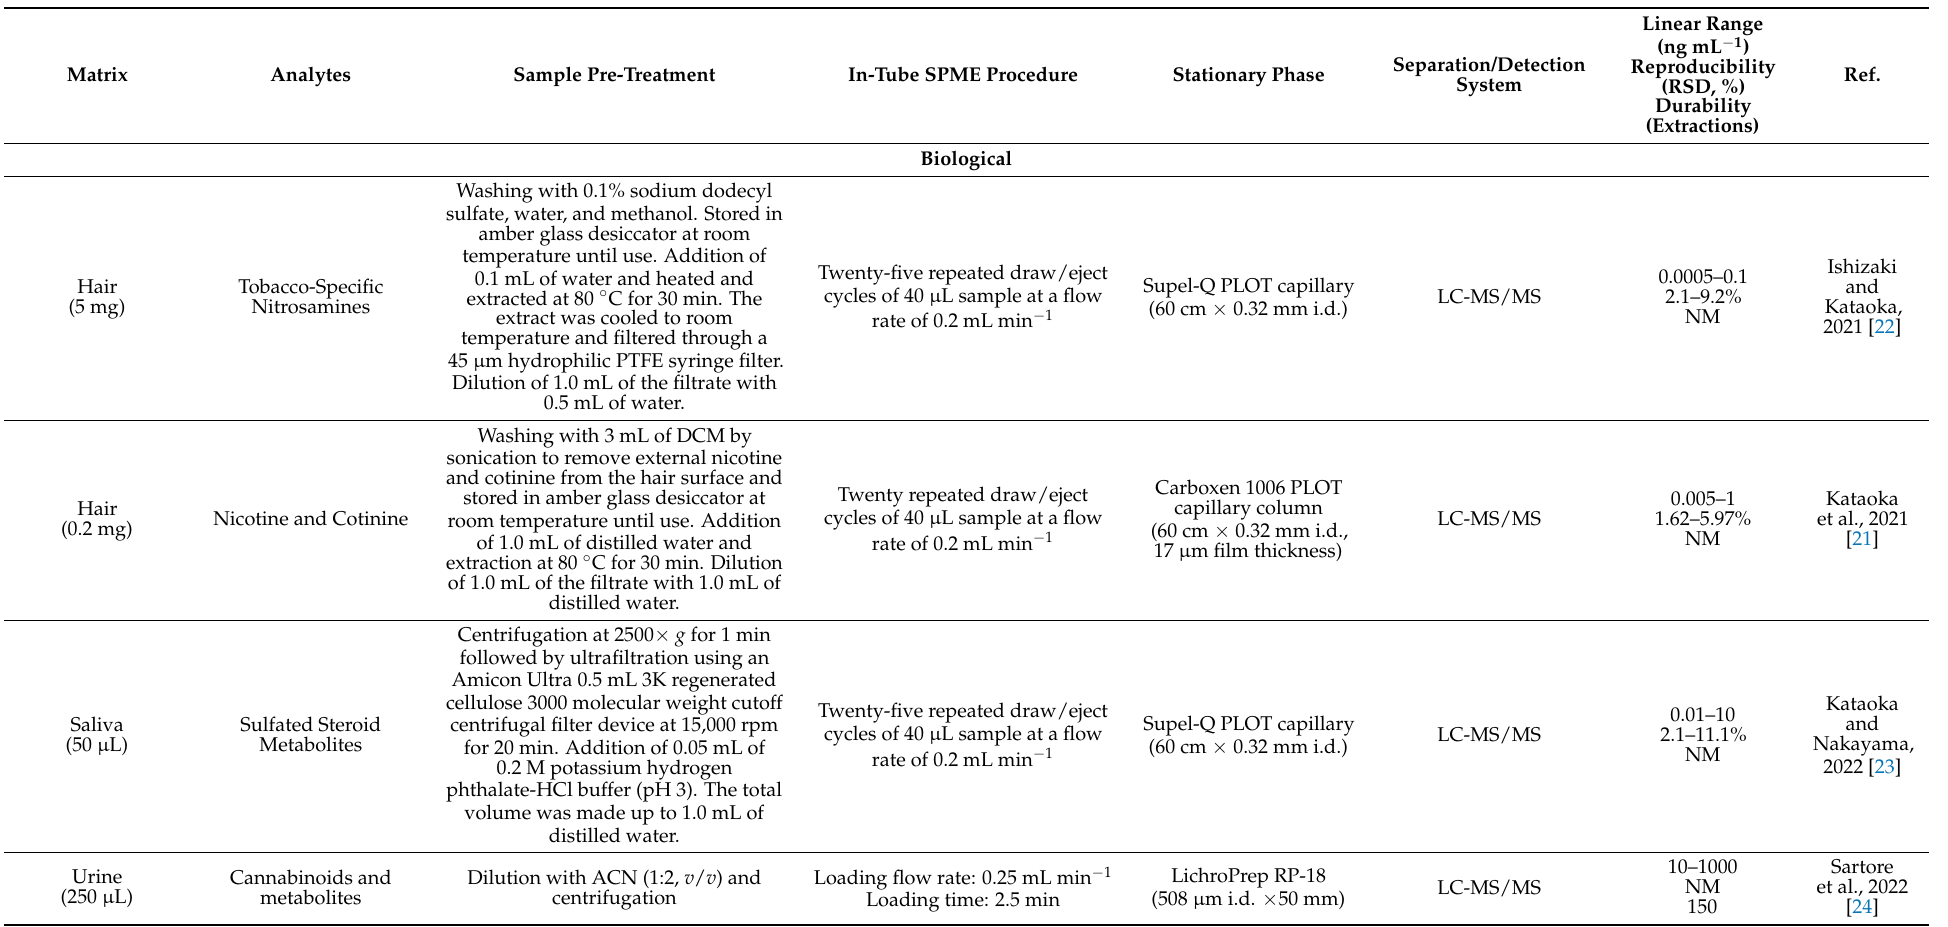
Table 2. In-tube SPME-LC